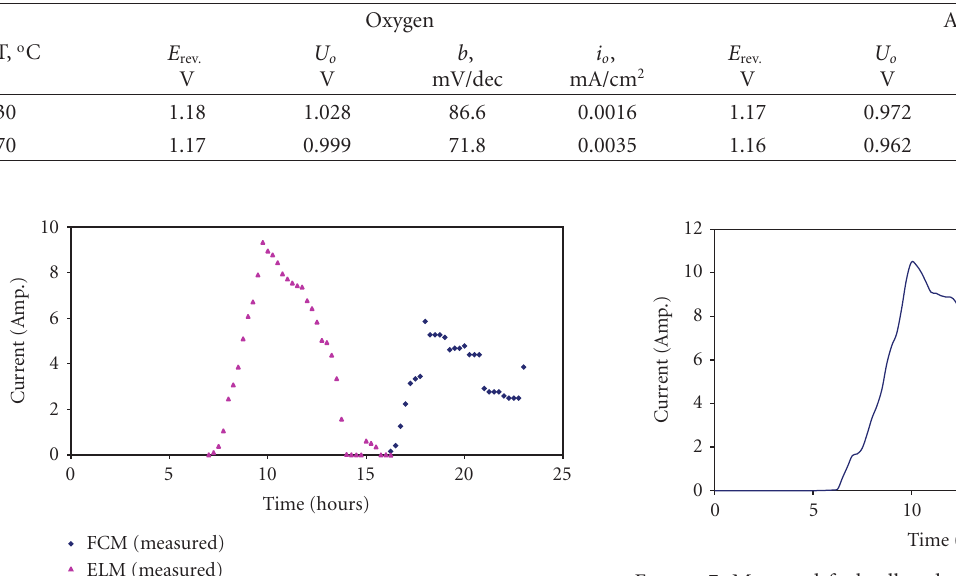
Figure 5: Fuel cell and electrolyzer mode measured current.